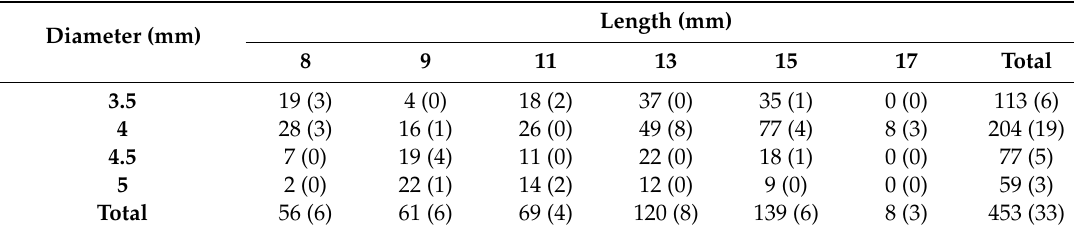
Table 4. Implant distribution according to implant diameter and length (implant failure is given between brackets).